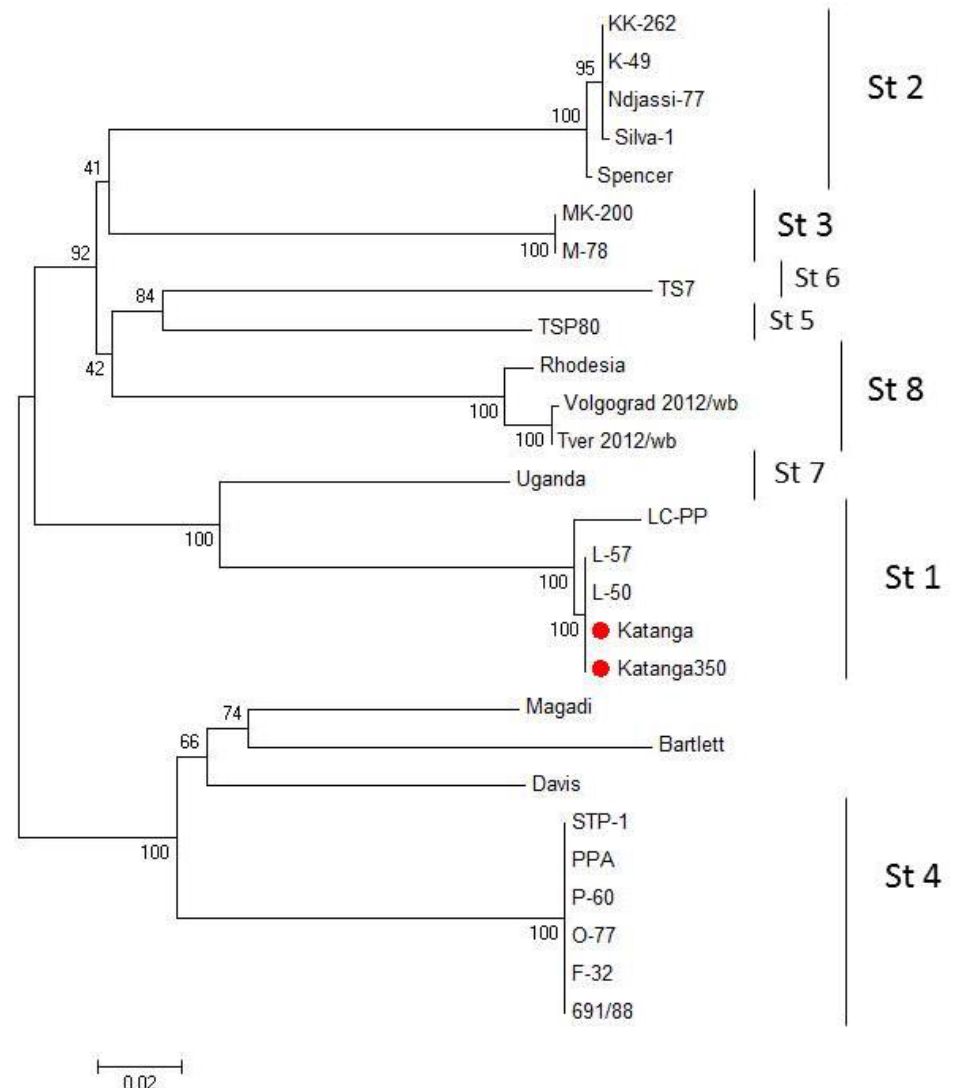
Figure 2. Maximum likelihood tree of ASFV CD2v and C-type lectin gene sequences (1000 bootstrapping replicates). Serotype status of typed viral taxa is indicated (St#). The ASFV strains, Katanga and Katanga-350, are indicated with a red circle.